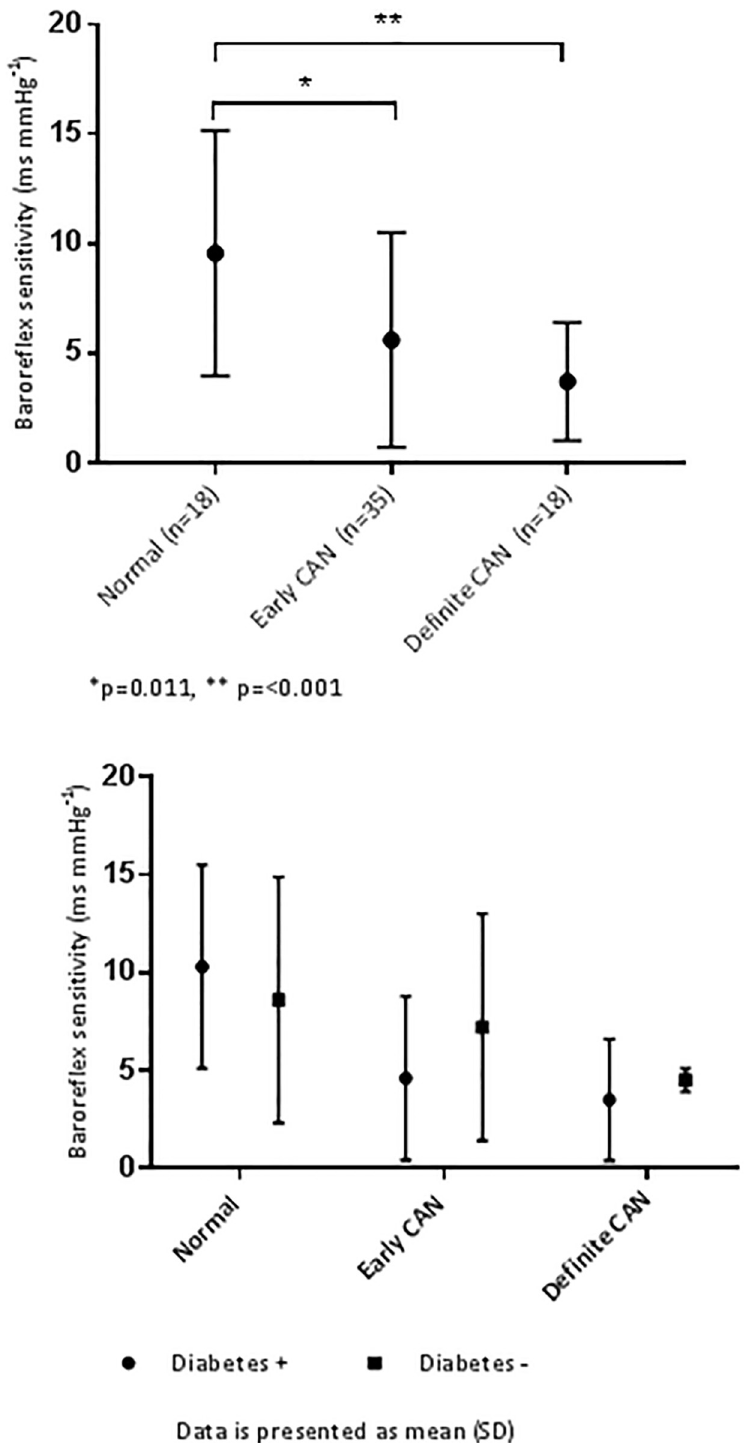
Fig 3. Level of agreement between stages of CAN and the baroreflex sensitivity. Upper panel: including all patients, Lower panel: separate for patients with and without DM.